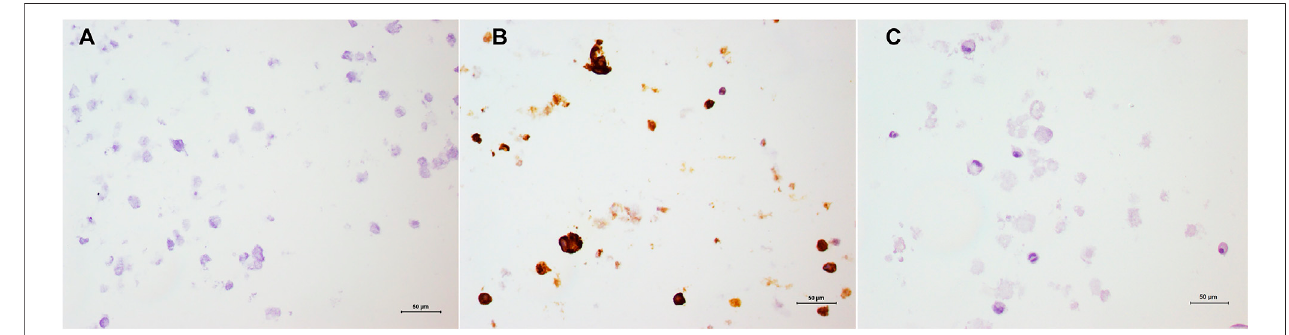
FIGURE10| Immunohistochemistry ofencapsulatedMSCs. (A) Negativecontrolofthesample; (B) Positive labelling ofCD44and C)Absence oflabelling byMHC II. Harris ’ hematoxylin counterstaining, 20x.